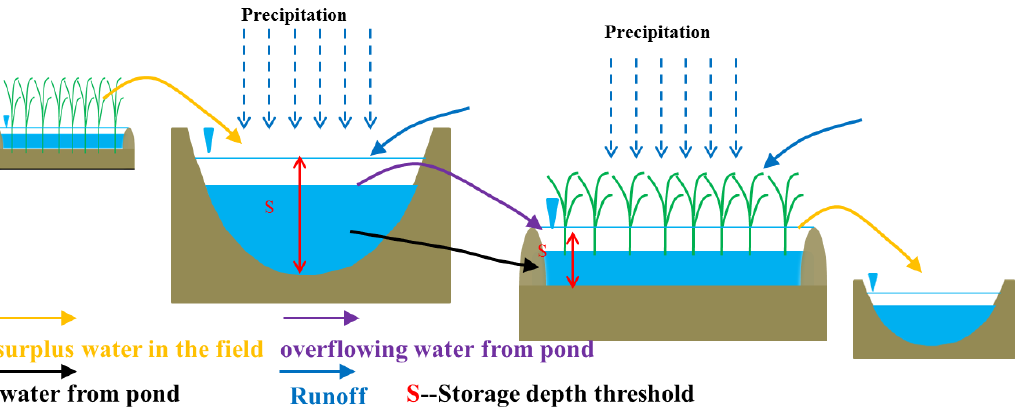
Figure 3. Schematic of water flow between ponds and farmland.